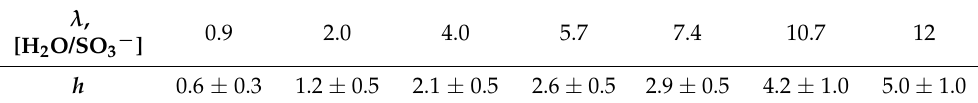
Table 3. Hydration numbers h of Li + cation in the lithium form of the Nafion 117 membrane at dif- ferent water contents λ . Reprinted with permission from Ref. [60]. Copyright © 2022 Elsevier B.V. All rights reserved.